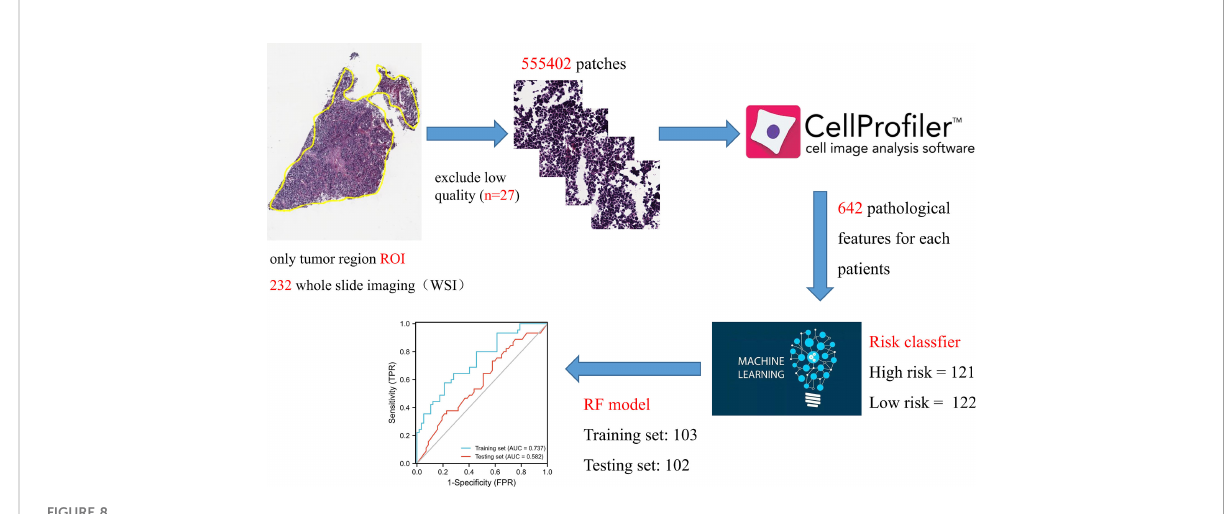
FIGURE 8 Schematic representation of pathogenomic